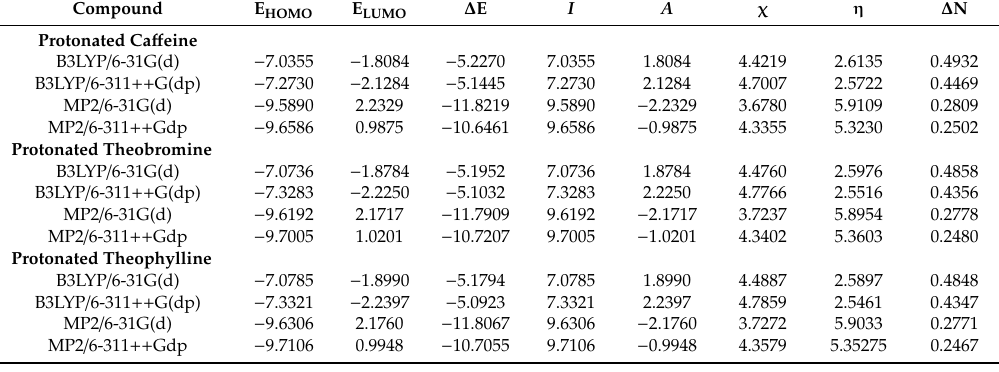
Table 5. The calculated quantum chemical parameters of protonated ca ff eine, theobromine, and theophylline in the aqueous phase at di ff erent theory levels. (All values are in eV). Compound E HOMO E LUMO Protonated Ca ff eine B3LYP / 6-31G(d)